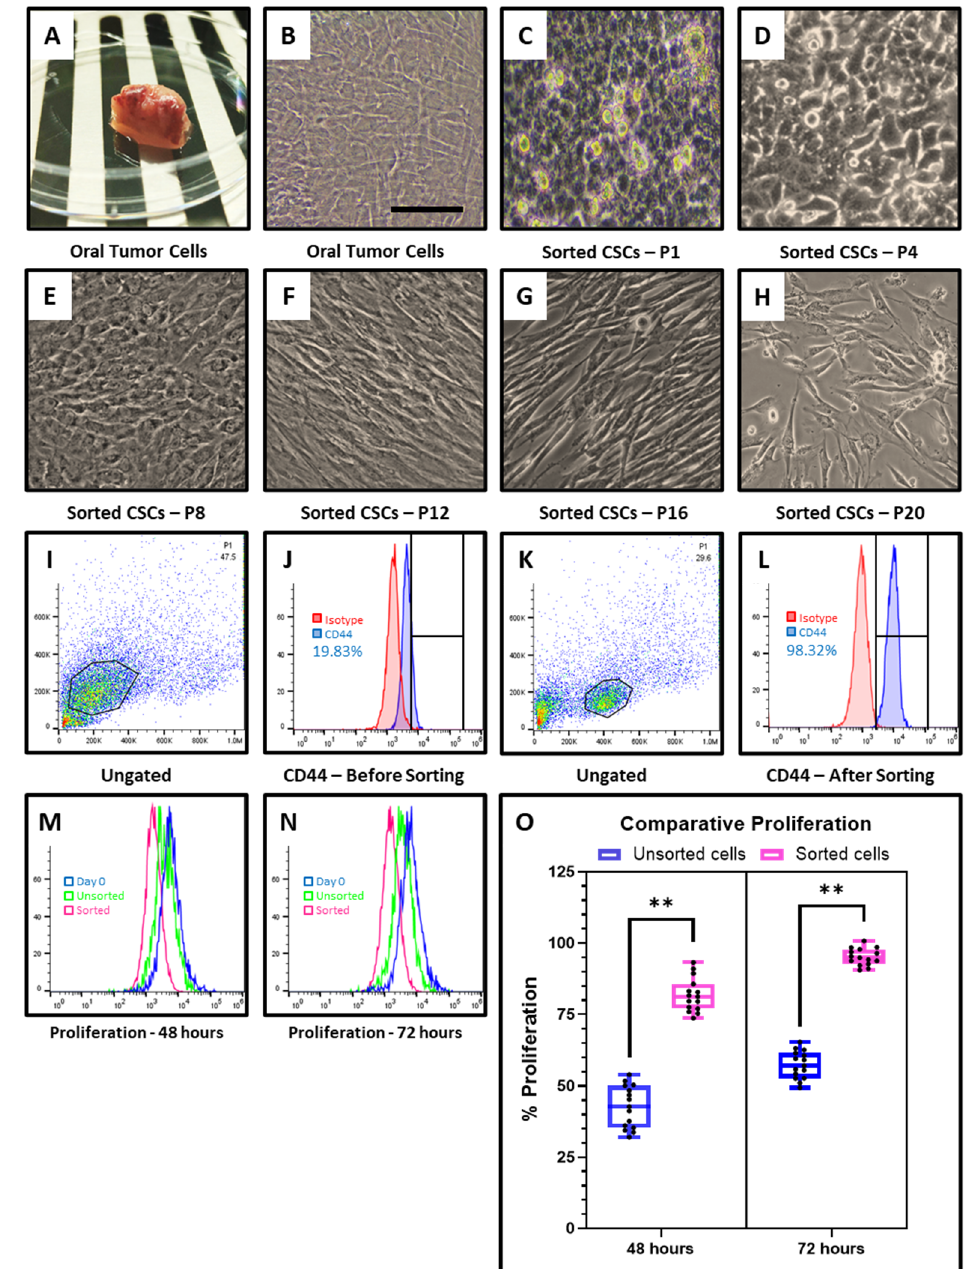
Figure 1. Preparation of the single cell suspension from OSCC tumor was carried out and the cells were subjected to flow cytometry and in vitro expansion. ( A ) OSCC tumor tissue. ( B – H ) In vitro cultured primary OSCC cells and sorted CD44+ cells at passage 1 to passage 20. Scale bar = 100 µm. ( I – L ) Flow cytometry analysis of OSCC cells and sorted CD44+ cells for expression of CD44 marker. Red: Isotype control; Blue: CD44 positive. ( M – O ) Comparative cell proliferation by CFSE assay. Blue: Day 0 MFI; Green: Unsorted MFI; Red: Sorted MFI. Experiments were performed in triplicates for all five samples independently. ns not significant, ** p < 0.01 .